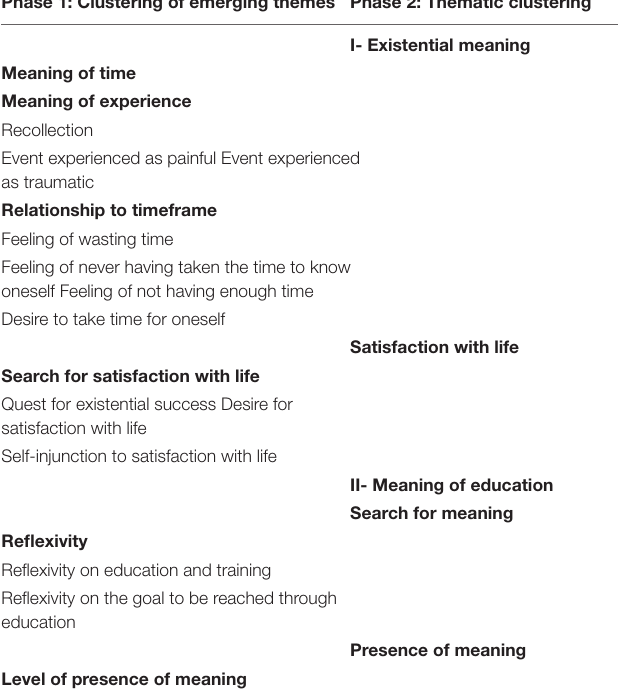
TABLE 2 | Extract of the various emerging themes and grouping by